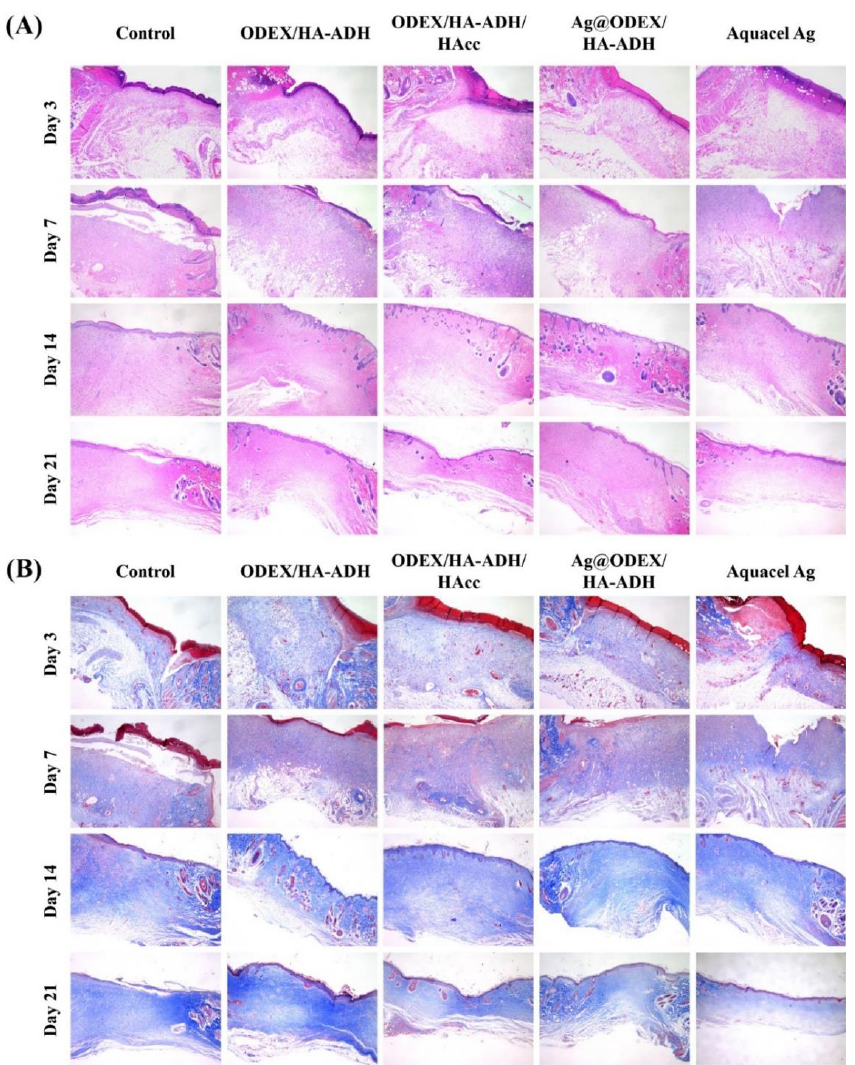
Figure 6. Histological analysis of the wound tissues with ( A ) H&E and ( B ) Masson’s trichrome stain- ing 3-, 7-, 14- and 21-days post- treatment, scale bar: 40 μ